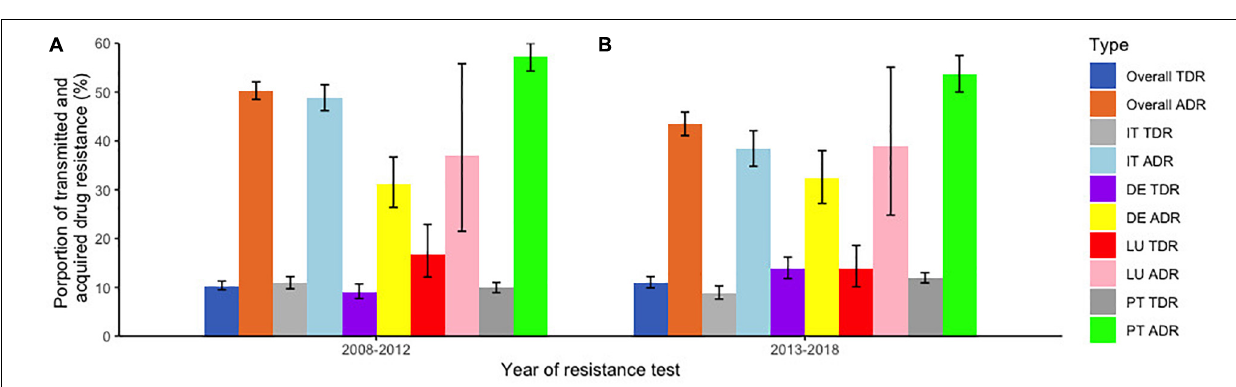
each country in those two time-periods, the TDR rate of Italy and Luxembourg decreased from one period to another (10.9% to 8.8%; 16.8% to 13.8%, respectively), while the rates